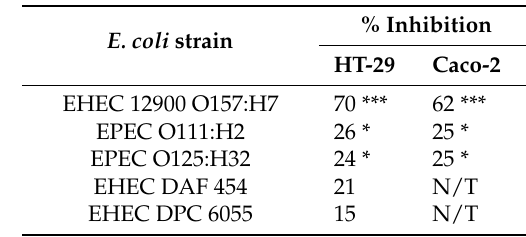
Table 1. The percentage inhibition of E. coli adherence to HT-29 and Caco-2 cells relative to the